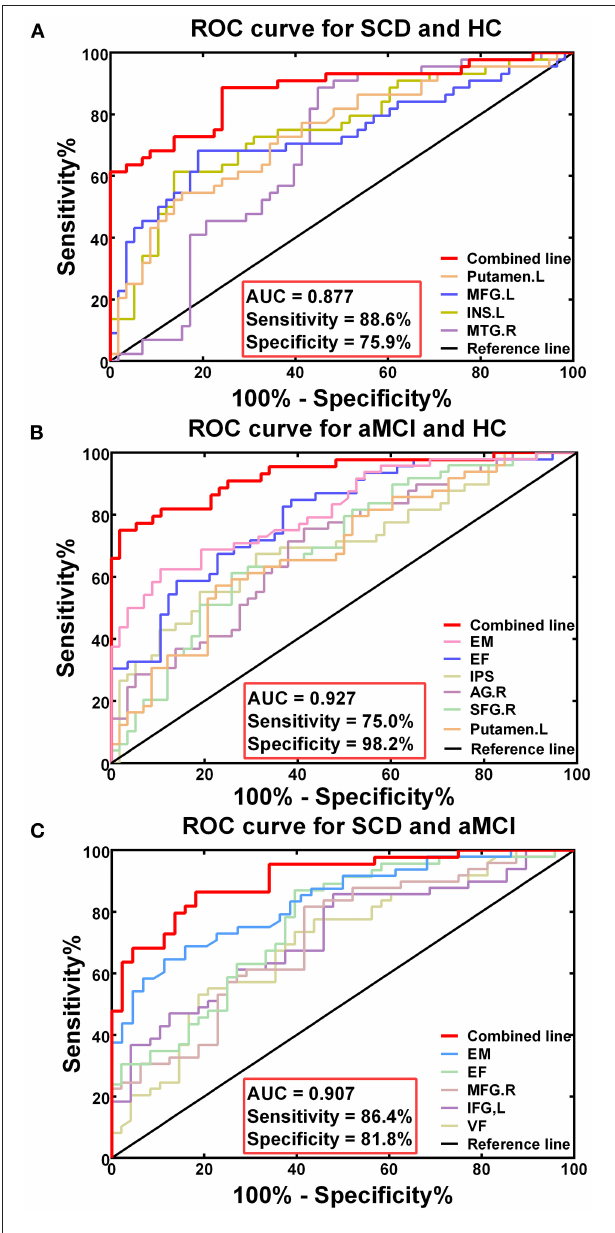
FIGURE 5 | Diagnosis and differentiation of SCD and aMCI based on ROC analysis. (A) The ROC curve showing the classification of SCD and HC; (B) The ROC curve showing the classification of aMCI and HC; (C) The ROC curve showing the classification of aMCI and